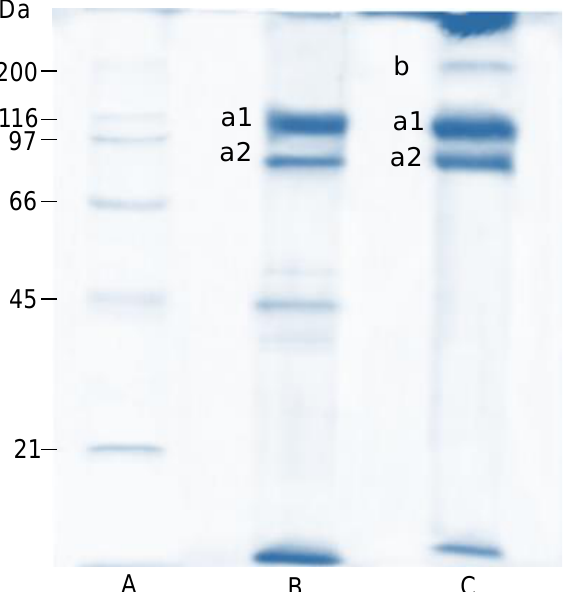
Figure 2. SDS-polyacrylamide protein pattern of jellyfish ( Stomolophus meleagris ) gelatin. Lane A: molecular weight marker; Lane B: umbrella; and Lane C: oral arms.